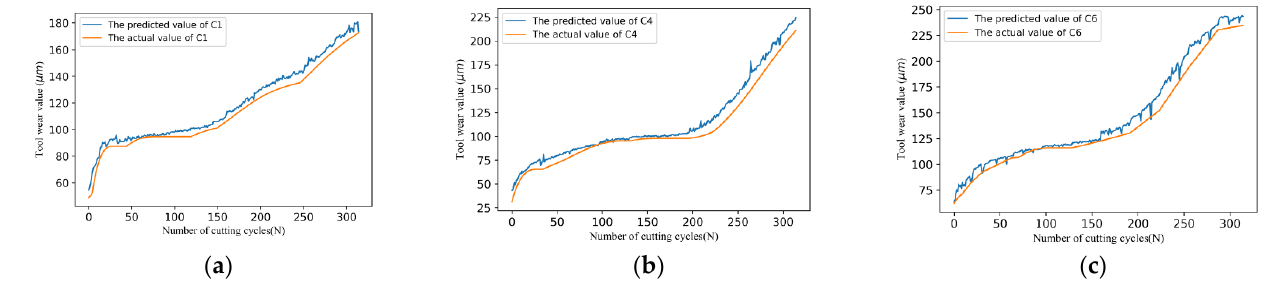
Figure 8. Prediction results of MSCNN+SE model on datasets. ( a ) C1, ( b ) C4, and ( c ) C6. 𝑃 𝑀𝐴𝐸 = 5.39 , 𝑃 𝑀𝑆𝐸 = 51.56 .